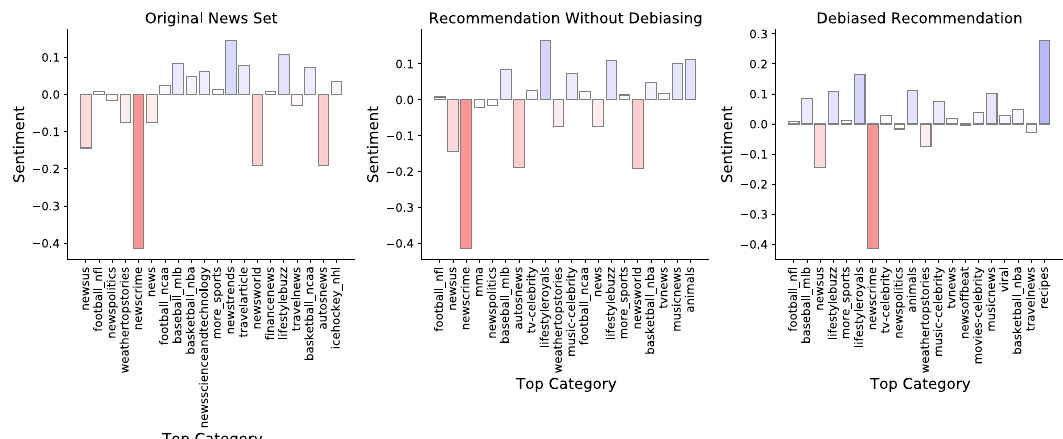
Fig. 6 Sentiment analysis of news topics. The top-frequency fi ne-grained news topic categories with their average sentiment orientations in the original news set, recommendations without debiasing, and debiased recommendations. The topic categories are sorted by their frequencies in descending order (from left to right). The results show that some topics with strong negative sentiment orientation are promoted by the biased recommender, while our debiased model demotes some negative news topics such as “ newscrime ” and promotes news topics with positive sentiment such as “ recipes ’’